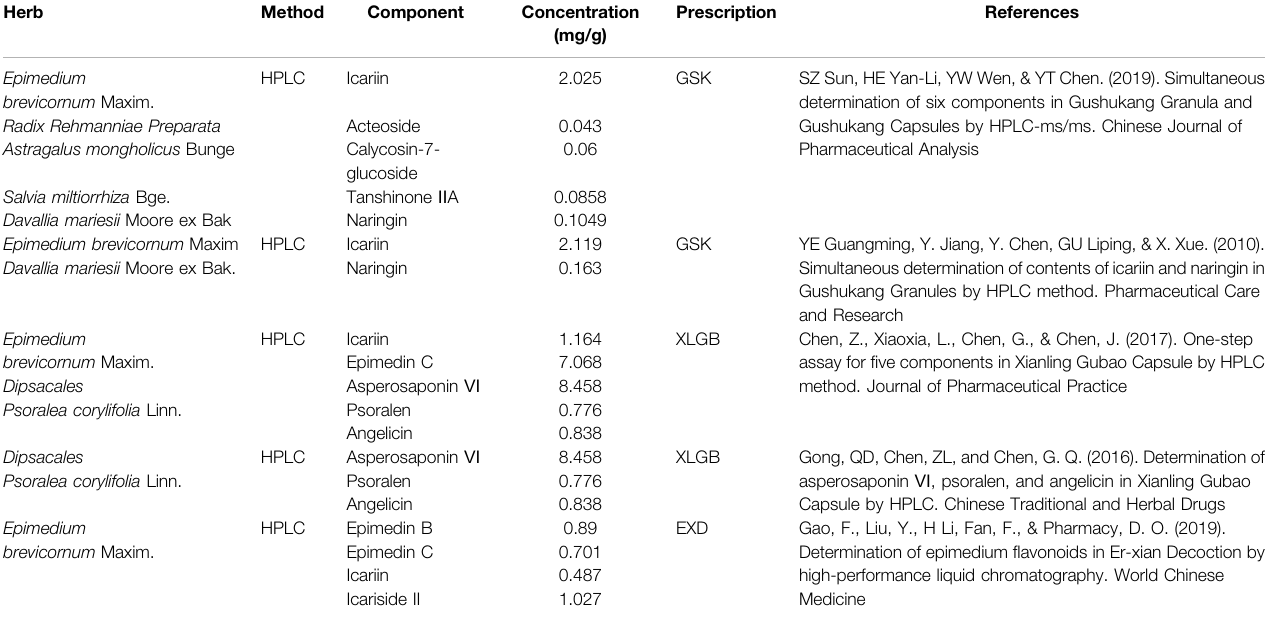
TABLE 1 | The experiments con fi rmed high concentration components of GSK, XLGB, and EXD. Herb